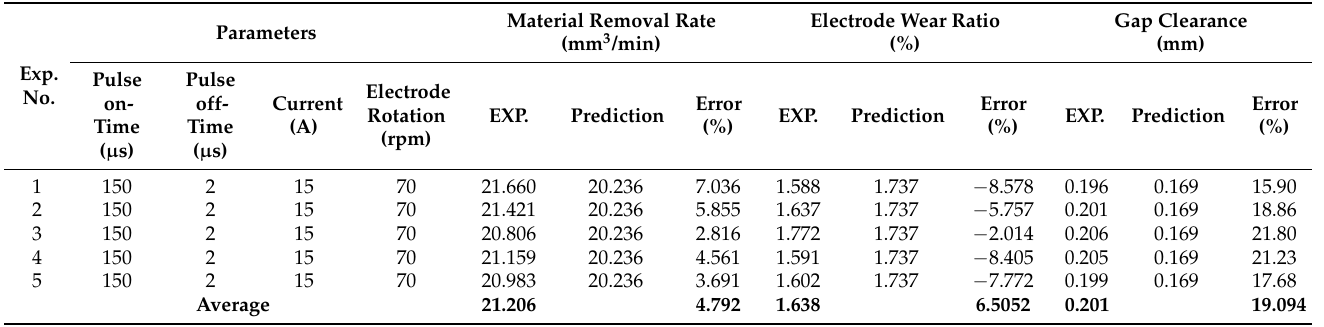
Table 12. The response surface methodology predicted and experimental results under the optimal machining condition of EDM with multi-aperture flushing.